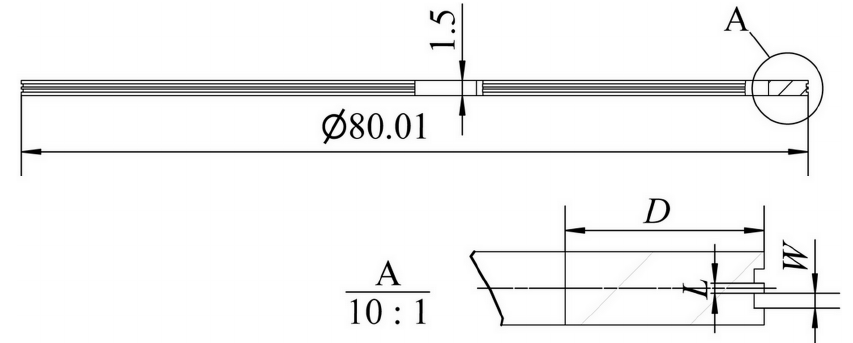
Figure 1. Piston ring with groove texture. Based on the size of the piston rings during the present study, the groove size param- eters of the piston rings were selected as the experiment factors, and the level values of the designed factors are shown in Table 1. Table 1. Factors and levels table of piston ring groove texture. Level